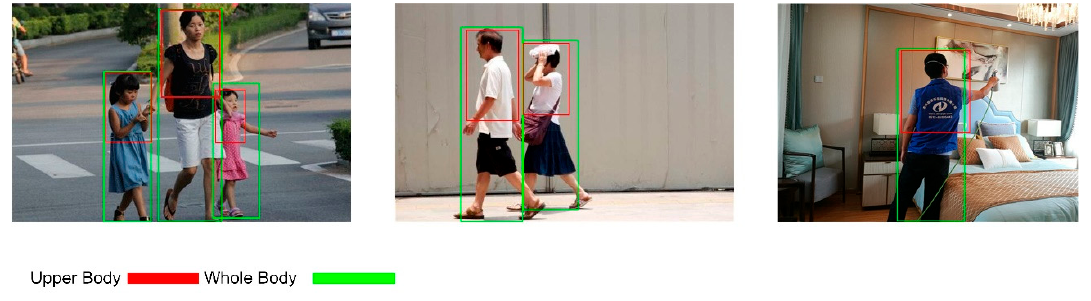
Figure 5. Sample images for training.